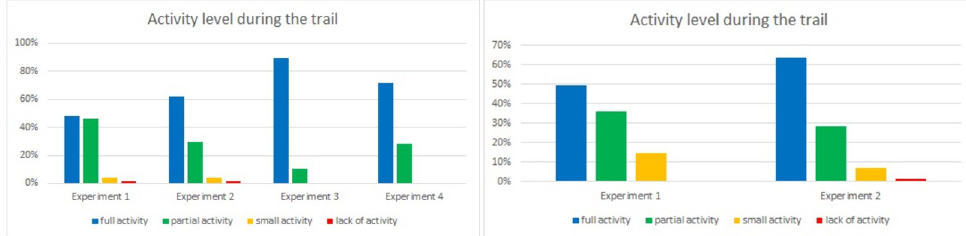
Fig 16. Evacuees activity level during consecutive experiments—question 7. (Results from the Laliki experiment are on the left; results from Gda ń sk are on the right).